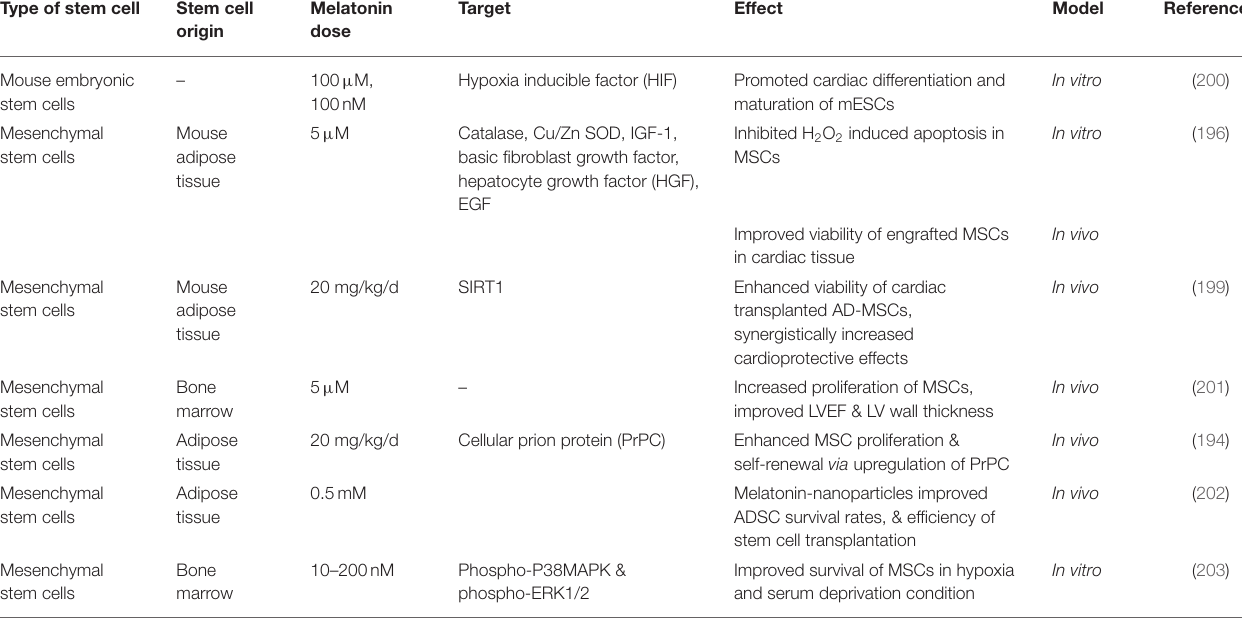
TABLE 2 | Studies on the synergistic effects of melatonin and progenitor cells for cardiac